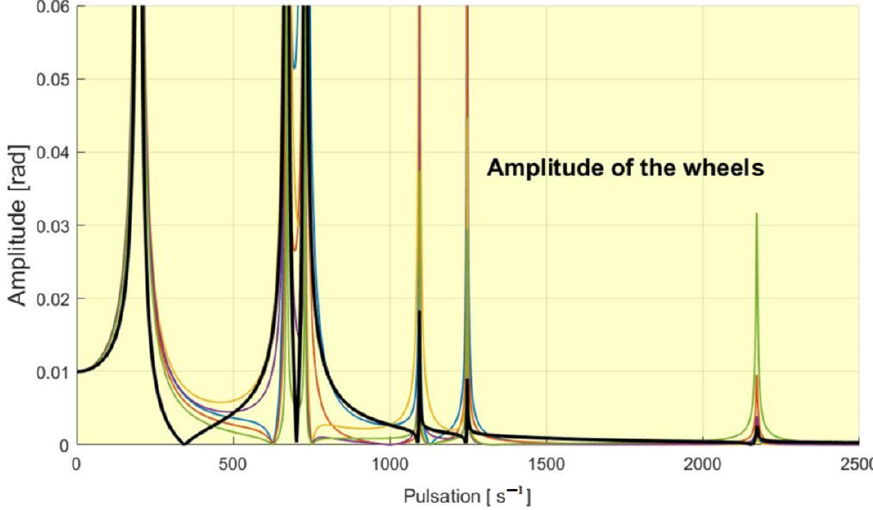
Figure 9. The amplitudes of the flywheels overlapped. With black is the graph for the flywheel 6. Table 3. The eigenpulsations of the system.